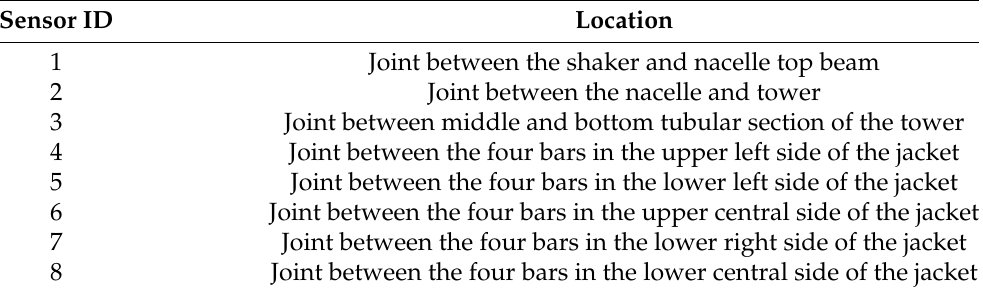
Table 1. Description of the eight sensors location in the structure.